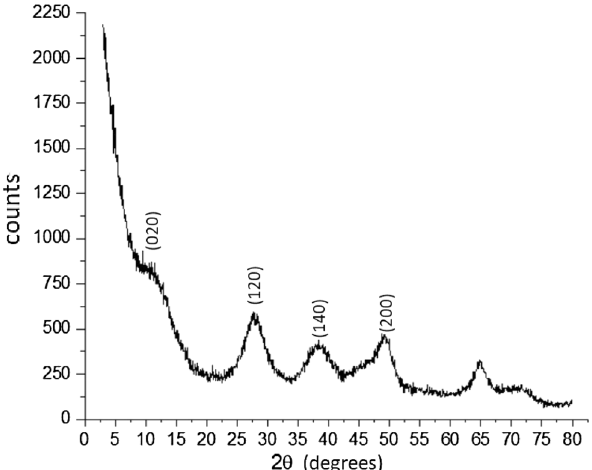
Figure 4. X-ray diffraction data of a pseudoboehmite sample.